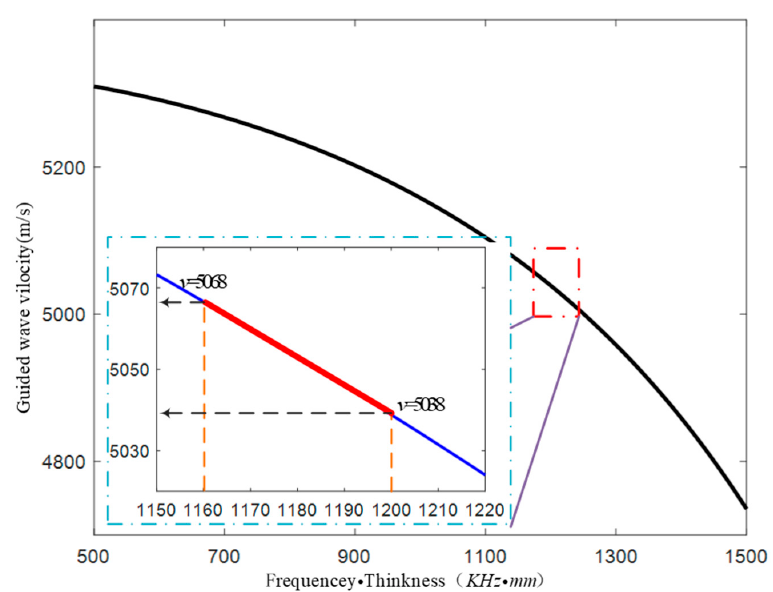
Figure 5. The setting of sound field threshold. Based on the dispersion curve, it can be deduced that the guided wave velocity boundary is 5068 corresponding to the defect recognition resolution of 0.1 mm.